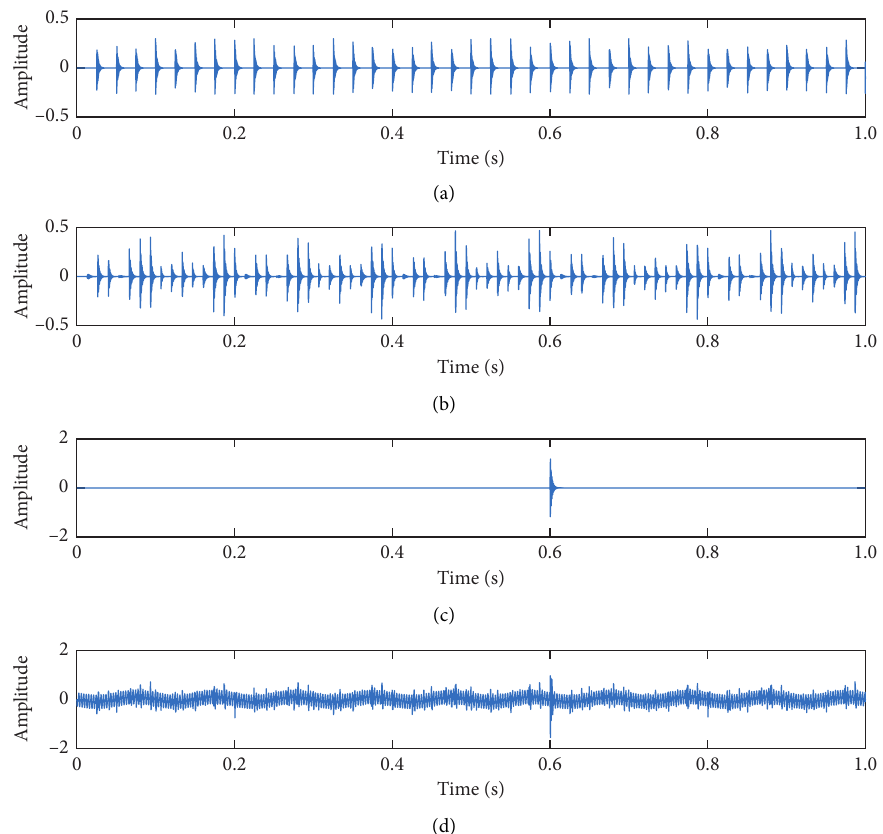
Figure 10: Simulated signals of case 2: (a) outer-race fault impulses, (b) inner-race fault impulses, (c) random impulse, and (d) pure signal.